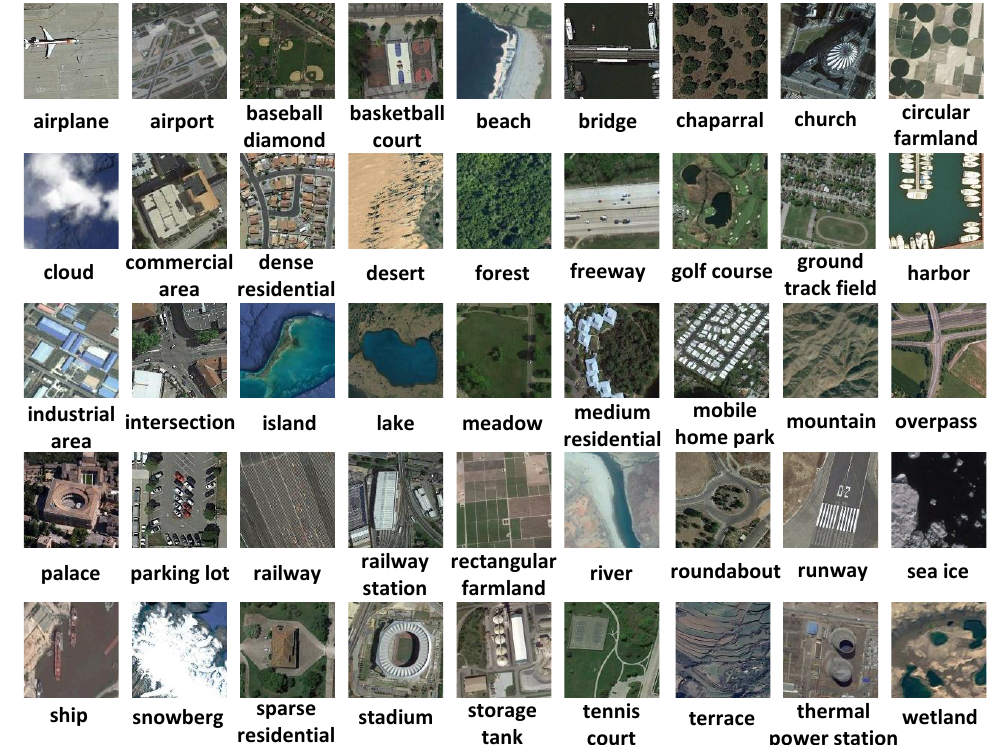
Figure 10. Examples of different categories in the NWPU